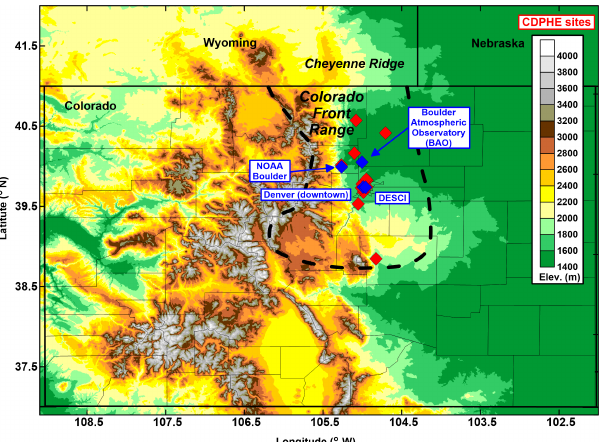
Figure 1. Map of monitoring locations, including NOAA DSRC in Boulder, which housed the PX-375 and TOPAZ lidar instruments; the BAO, where the 449MHz wind profiler was deployed; down- town Denver; the CDPHE DESCI site, where atmospheric extinc- tion/visibility is measured; and the CDPHE sites where PM 2 . 5 and PM 10 are monitored (see Table 1 for site descriptions). The approx- imate area encompassing the Colorado Front Range is highlighted by the dashed line. The Cheyenne Ridge in Wyoming is also no-